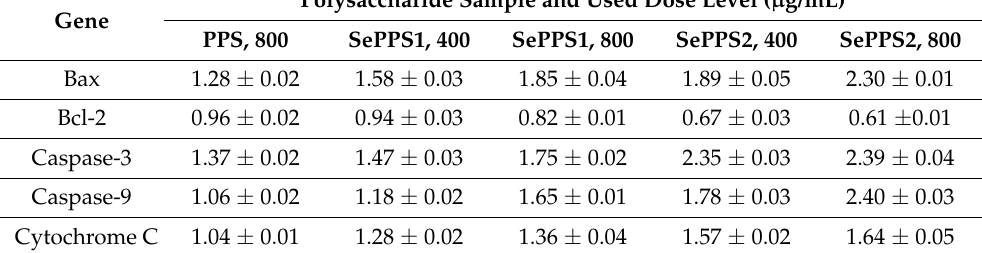
Table 4. Relative gene expression folds of HCT-116 cells treated with PPS, SePPS1, and SePPS2 for 24 h.